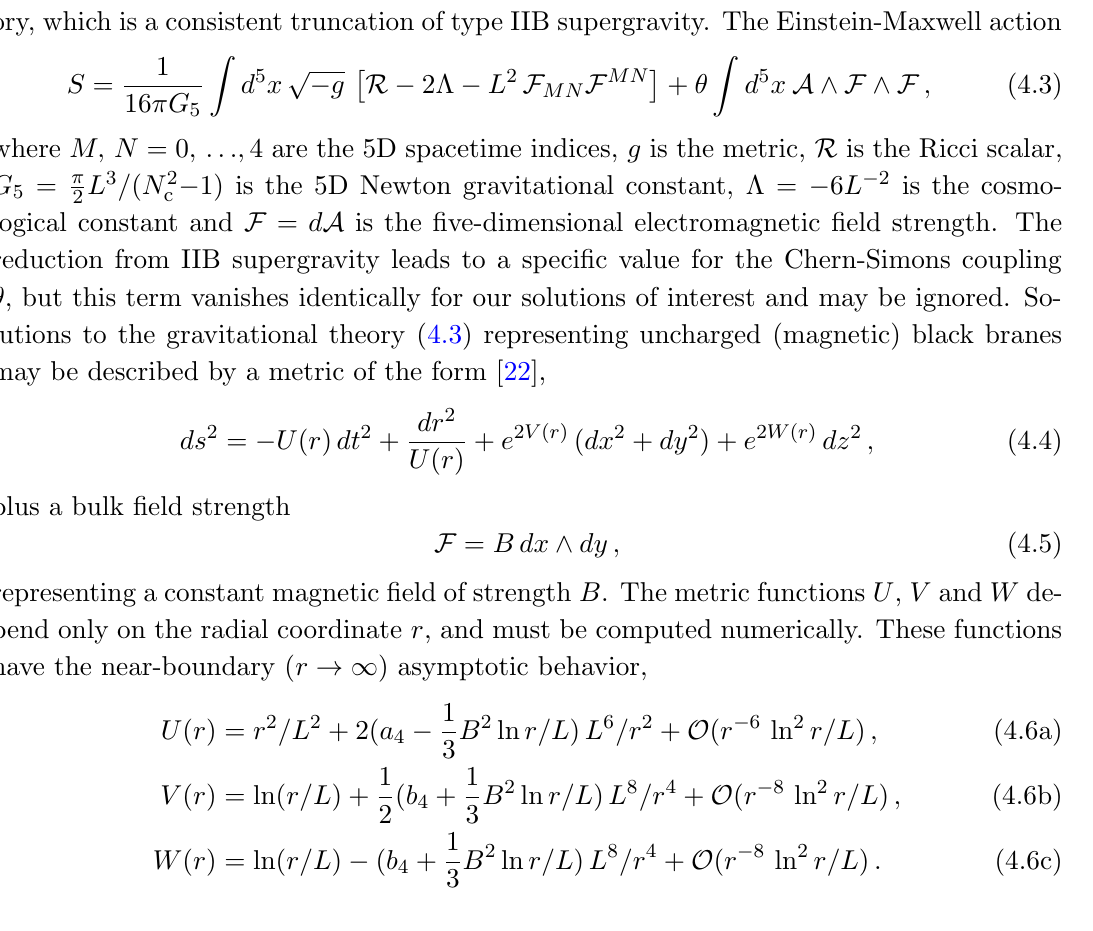
Figure 4 . The ratio p L =(cid:15) at the renormalization point (cid:22) = T (left panel) and p T =(cid:15) at (cid:22) = (cid:3) H (right panel) for various values of the magnetic (cid:12)eld B , and plotted as a function of T= the ratio p T =p L , no near universal behavior is observed in either ratio involving the energy